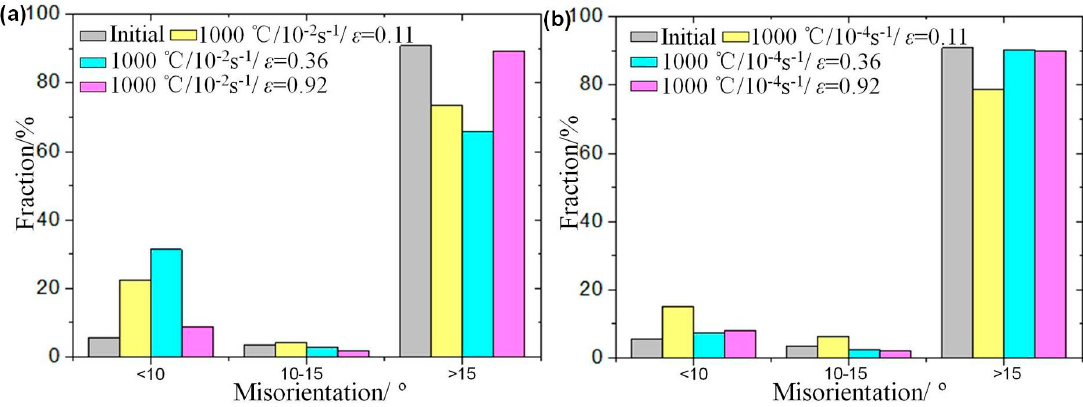
Figure 10. Histogram of γ grain boundary misorientation at different angle scopes for the alloy deformed to different strains at 1000 °C with the strain rate of 10 − 2 s − 1 ( a ) and 10 − 4 s − 1 ( b ).